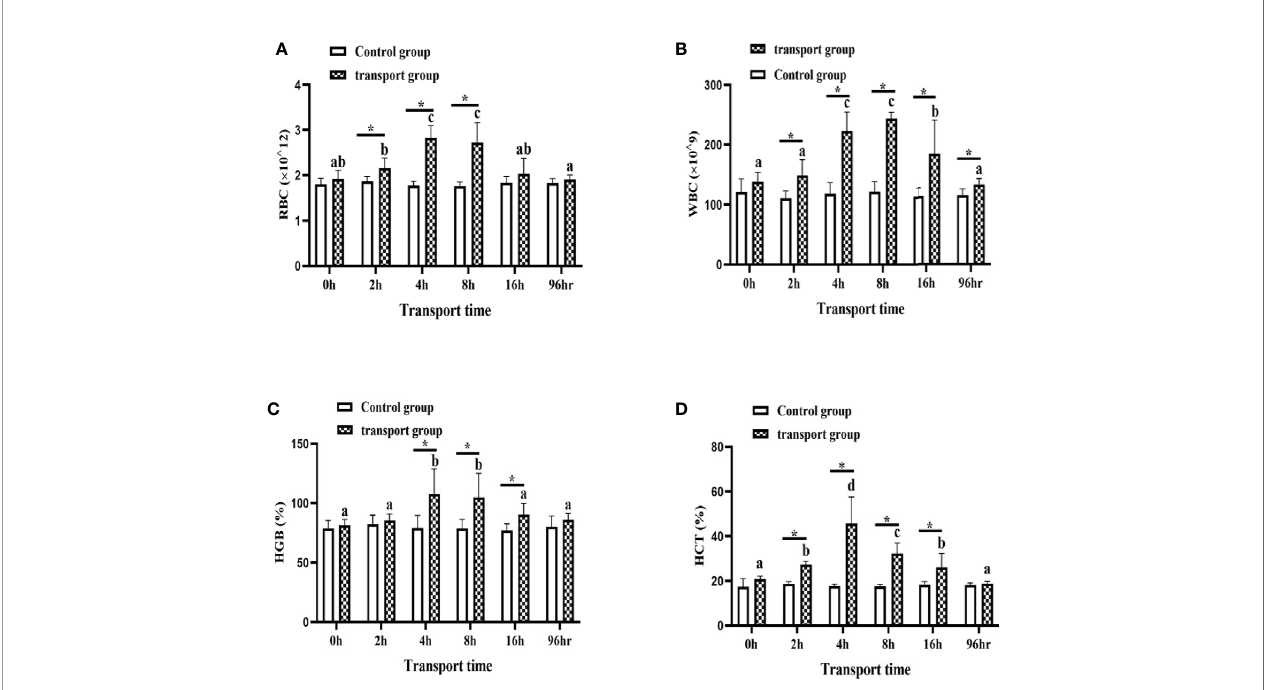
FIGURE 2 | Amounts of white blood cells (WBC) (A) and red blood cells (RBC) (B) and levels of hemoglobin (HGB) (C) and hematocrit (HCT) (D) in transported and recovery groups. Values are mean ± SD ( n =12). Asterisk (*) indicates signi fi cant difference ( P < 0.05) between control group and transport group. Different small letters indicate signi fi cant differences ( P < 0.05) among sampling times in the same